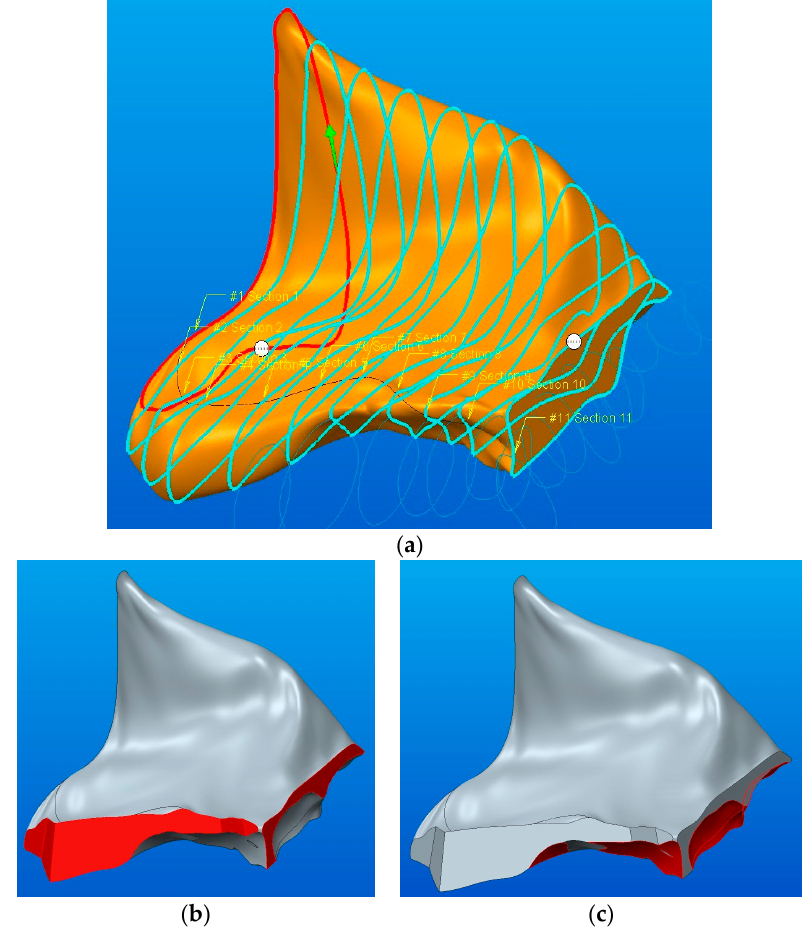
Figure 12. The achievement of the A component — results of the following functions: ( a ) Blend — parameterized model; ( b ) Extrude Cut — obtaining straight edges and flat surfaces; ( c ) Blend Cut — obtaining curved